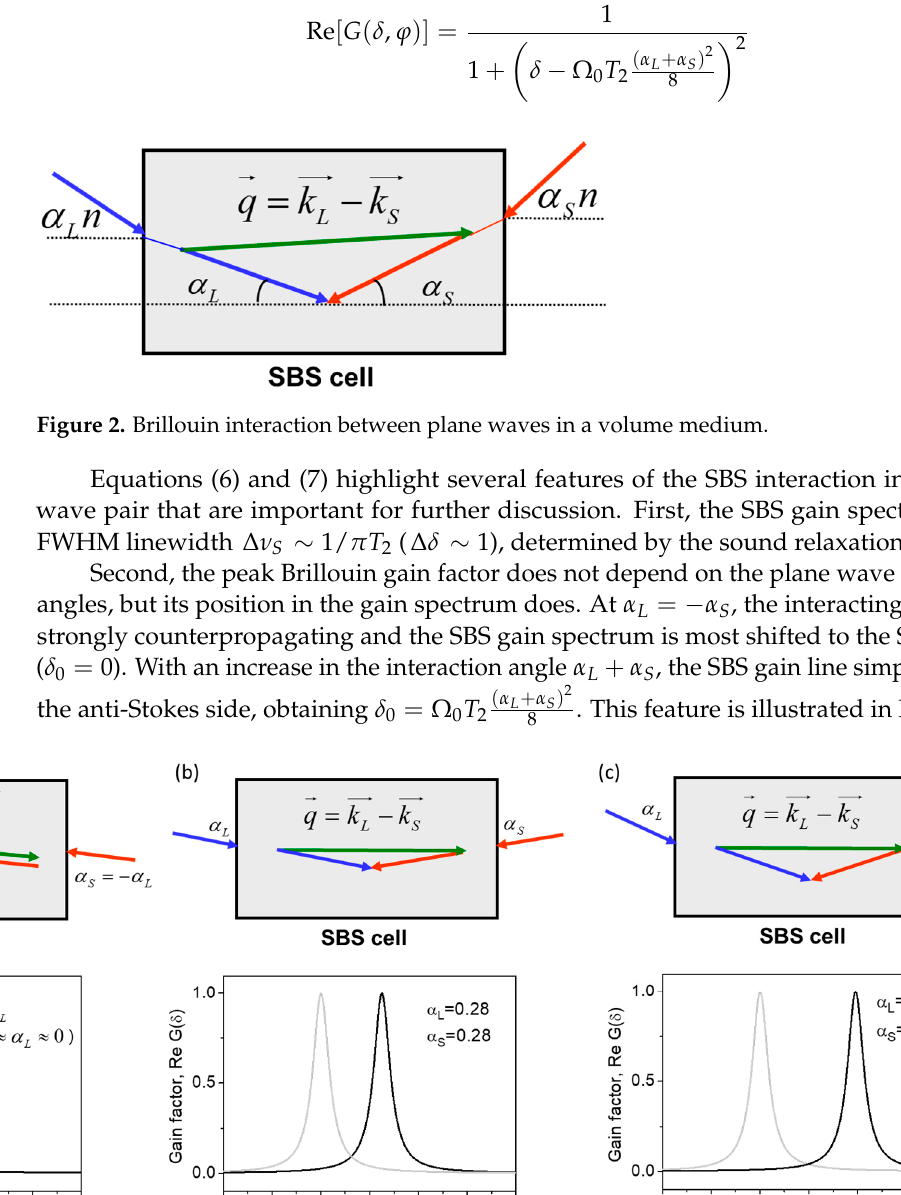
Figure 3. Brillouin gain spectra describing interaction between plane waves in a volume medium at different angles ( a – c ). Calculations are performed using Equation (7).